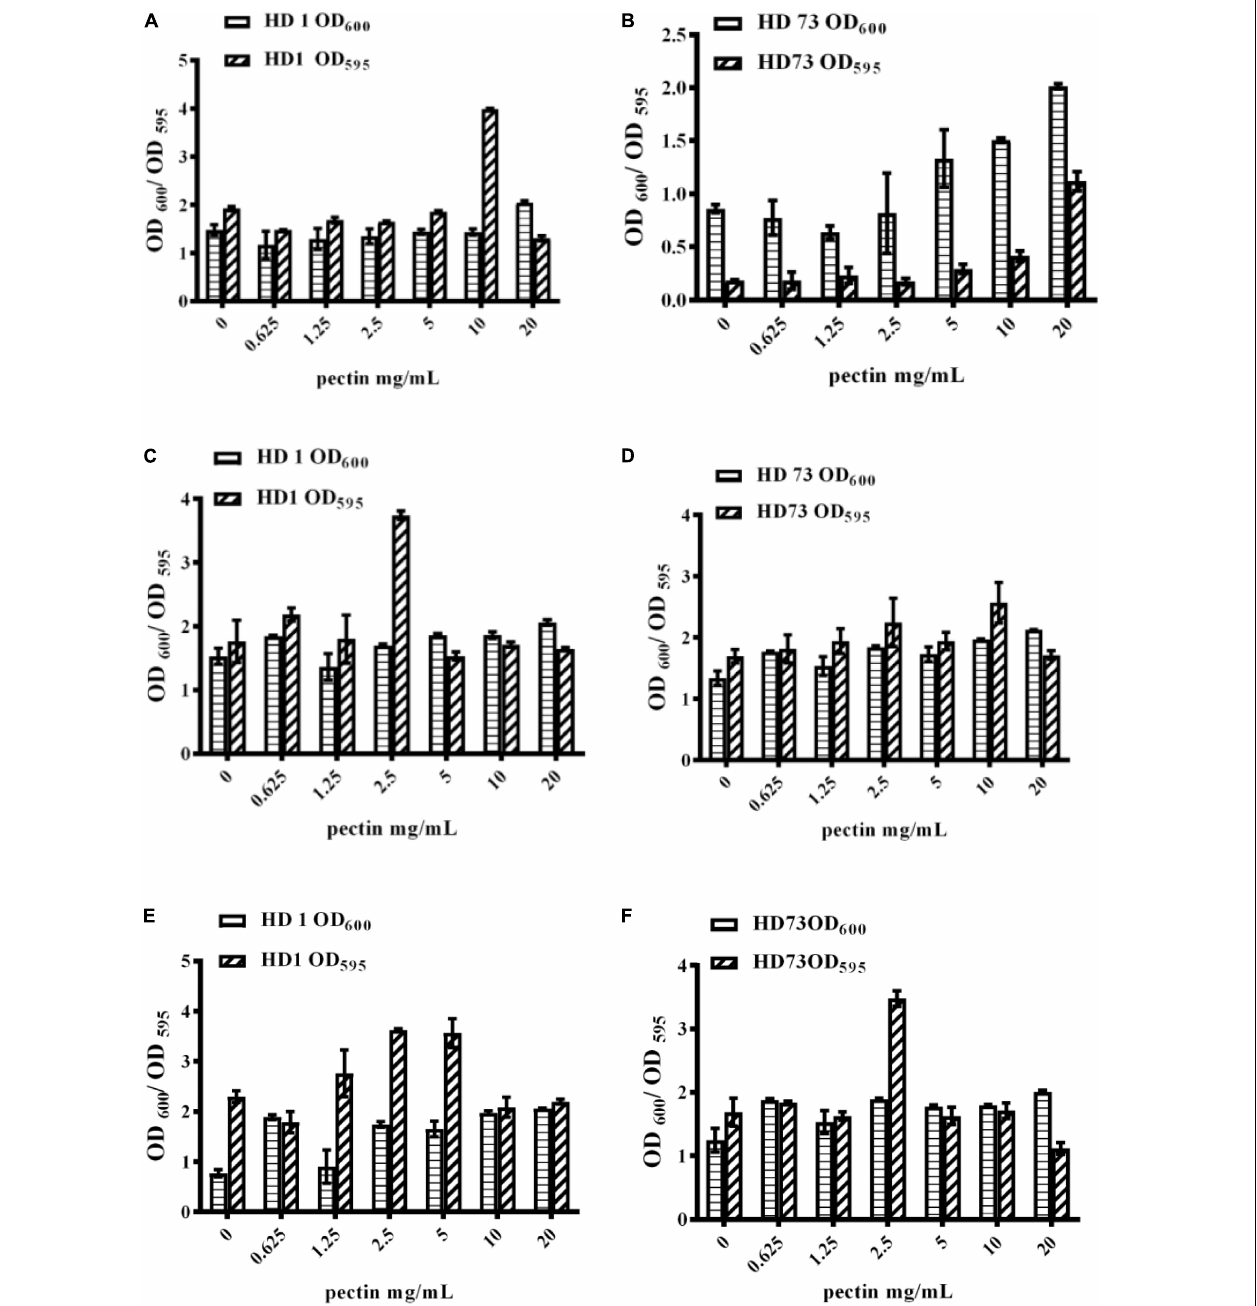
FIGURE 4 | Effects of pectin dosage on the biofilms formed by Bt cells in different growth phases at the solid–liquid interfaces. (A,B) The logarithmic growth phase cells of Bt HD1 and HD73, respectively. (C,D) The sporangial phase cells of Bt HD1 and HD73, respectively. (E,F) The lysis phase cells of Bt HD1 and HD73,